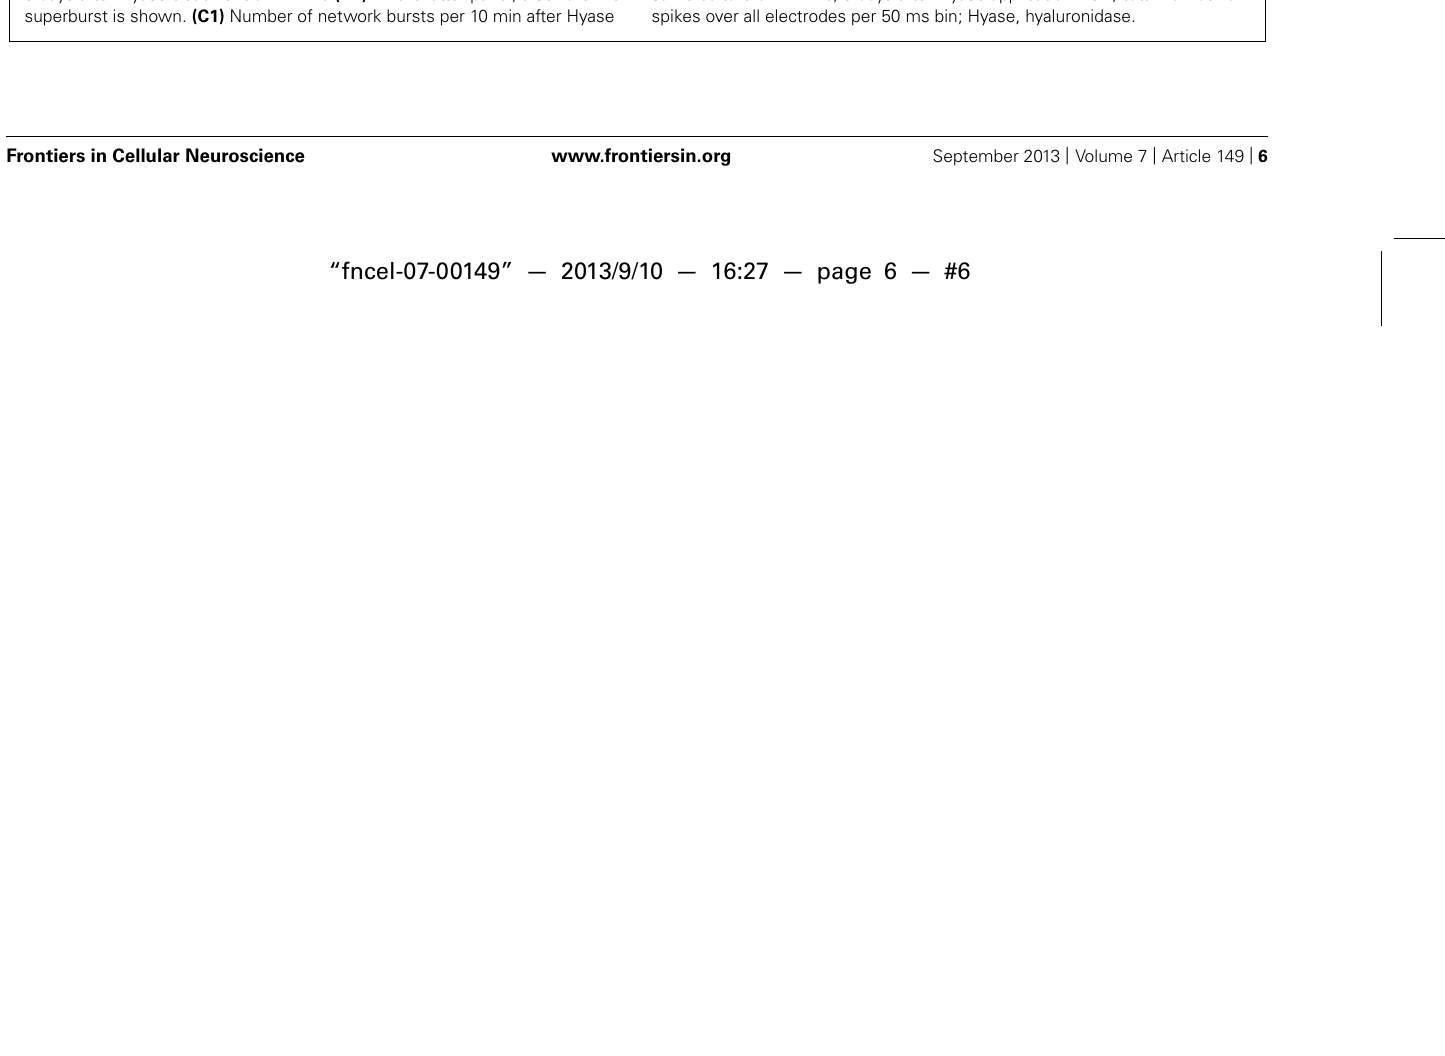
FIGURE 3 | Raster plots of electrical spiking activity over 64 electrodes (lower rows) and total spike rate diagram (upper row) in primary hippocampal cultures (A1–A4,B1–B4) . Hippocampal neuronal network activity in intact cultures on the 17th DIV (A1,B1) . (A2,A3) Neuronal network activity in control cultures on DIV 19 (A2) , DIV 20 (A3) , and DIV 26 (A4) . (B2–B4) Development of activity in Hyase-treated cultures 2 days after Hyase treatment on DIV 19 (B2) , 3 days after Hyase treatment on DIV 20 (B3) , and 9 days after Hyase treatment on DIV 26 (B4) . In the latter panel, a seizure-like superburst is shown. (C1) Number of network bursts per 10 min after Hyase